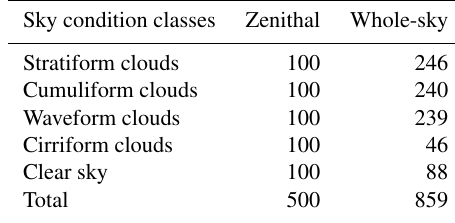
Figure 1. System framework.